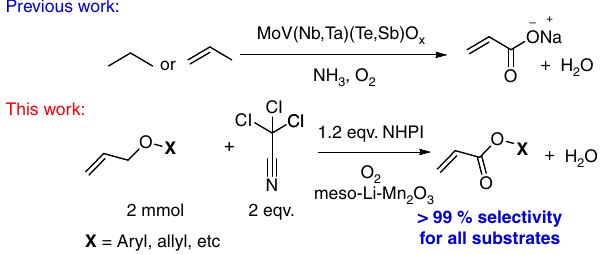
Fig. 1 Schematic representation of the plausible reaction mechanism in presence of PINO, MeCN, and O 2 . This mechanistic scheme identi fi es all of the reaction intermediates, shows the various surface manganese oxide species used in the catalytic reaction, and shows a detailed set of pathways that account for observed products